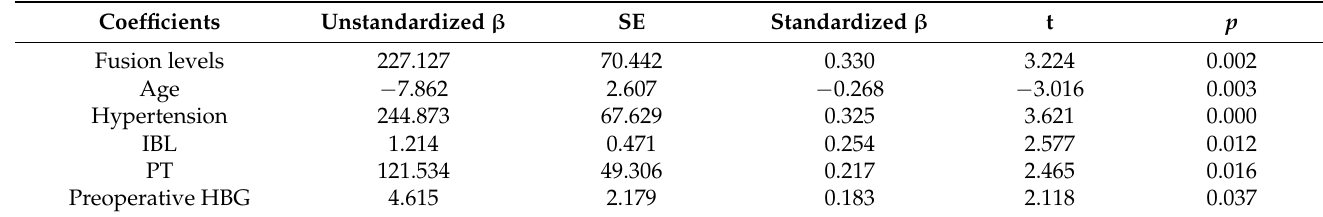
Table 4. Results of multivariate linear regression analysis for hidden blood